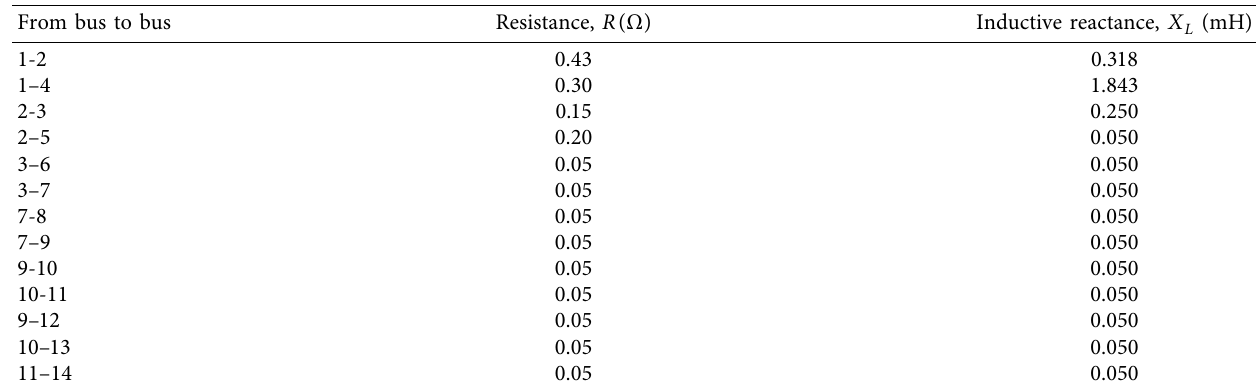
Figure 10: Microgrid Test System. Table 2: Line data.